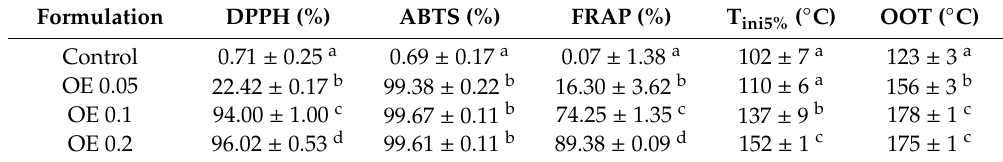
Table 4. Antioxidant activity and thermal parameters obtained for edible films. Mean ± SD ( n = 3). Formulation